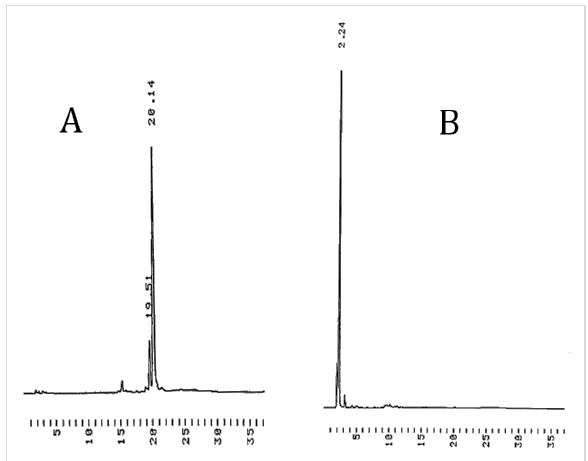
Figure 1: HPLC traces referring to precipitation of the tetrapodal support bearing fully protected UU-dimers ( 9 ), i.e., after the oxidation step: (A) stands for the precipitate and (B) for the filtrate after the precipitation. Chromatographic conditions: a Thermo ODS Hypersil C18 (250 × 4.6 mm, 5 µm) column eluted with a mixture of MeCN and aq Et 3 N (0.1 mol L − 1 ) at flow rate 1 mL min − 1 . A linear gradient from MeCN 25% at t = 0 min to MeCN 100% at t = 25 min.